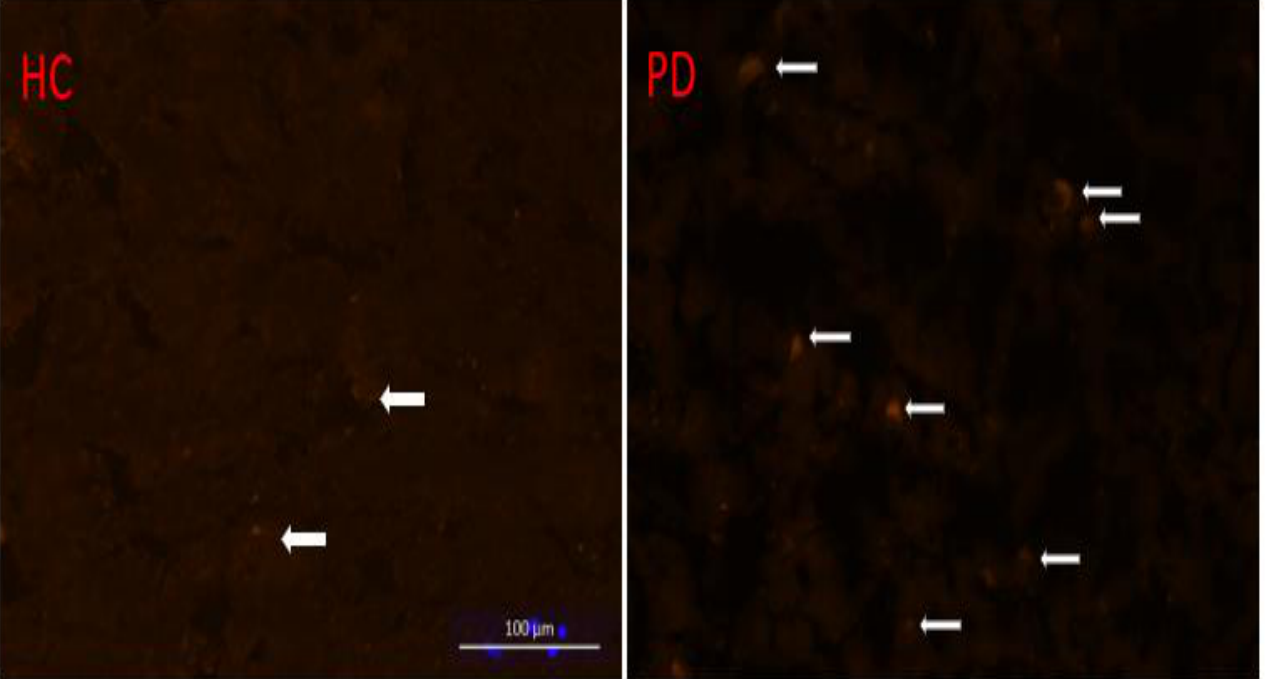
Figure 6. iNOS histology of the middle frontal gyrus showing greater expression in PD ( right ) compared to a healthy control ( left ). White arrows indicate regions of iNOS expression. The authors wish to acknowledge the late Dr. John Trojanowski for this figure.